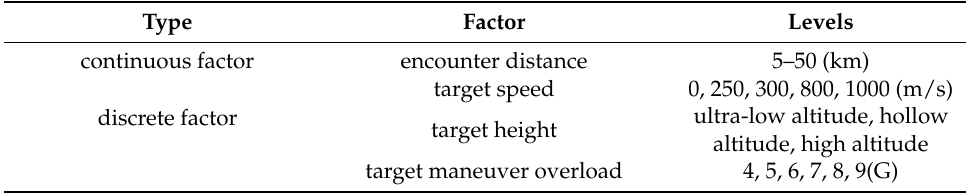
Table 2. Experimental actors.